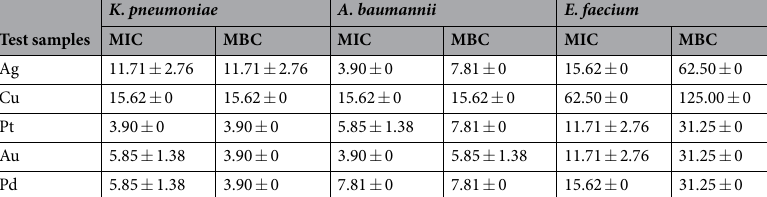
Table 2. Minimal inhibitory concentration and minimal bactericidal concentration (mgL − 1 ) values for the metals against tested three bacteria demonstrating that platinum and gold displayed the most inhibitory concentrations and platinum, gold and palladium demonstrated the most potent MBCs. Au = gold, Cu = copper, Pt = platinum, Pd = palladium and Ag = silver (n =